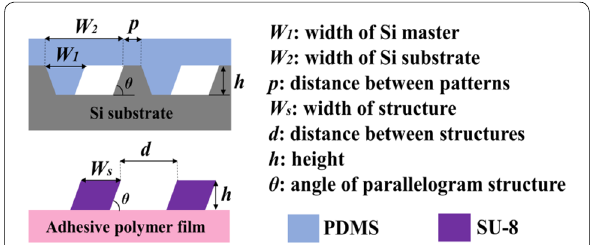
Fig. 1 Schematic view of anisotropic surface with parallelogram structures and their various geometrical parameters